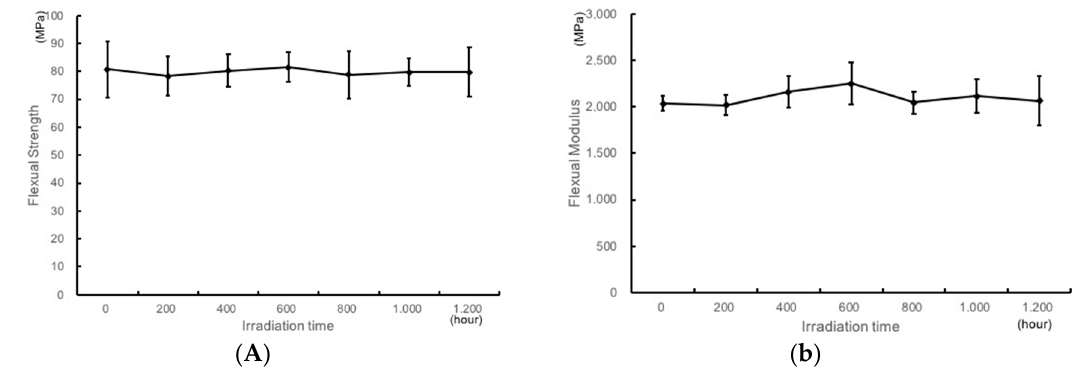
Figure 4. Flexural strength ( A ) and Flexural modulus ( B ) of the TiO 2 -coated resin plates upon UV irradiation.